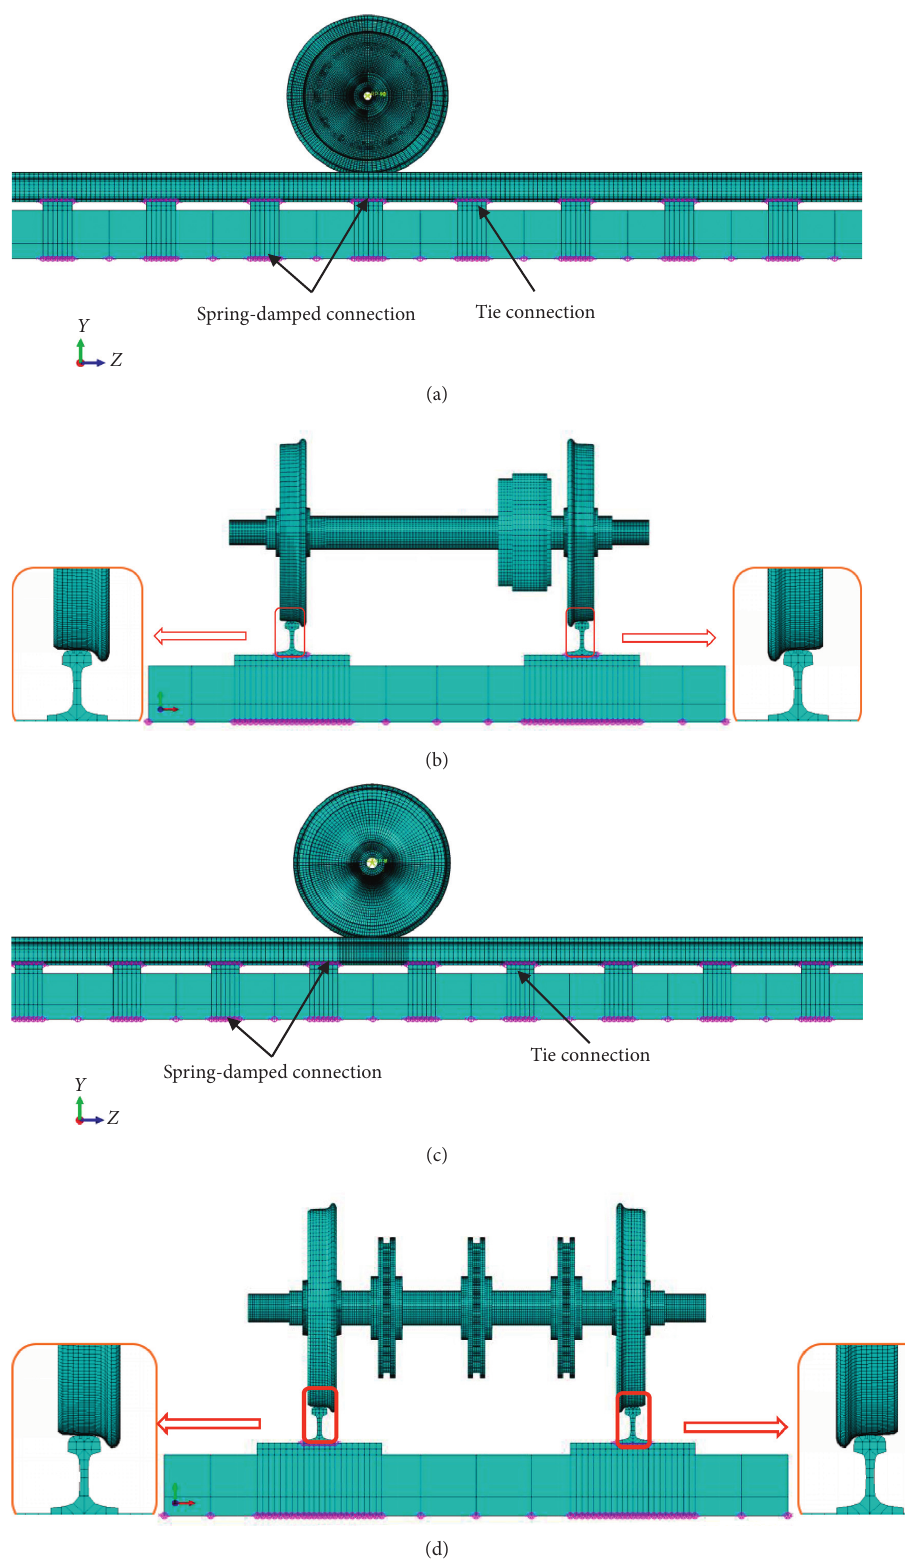
Figure 4: Finite element models of the power and trailer wheelset-track system: (a) left view of the power wheelset-track system, (b) front view of the power wheelset-track system and contact details between wheel and rail, (c) left view of the trailer wheelset-track system, (d) front view of the trailer wheelset-track system and contact details between wheel and